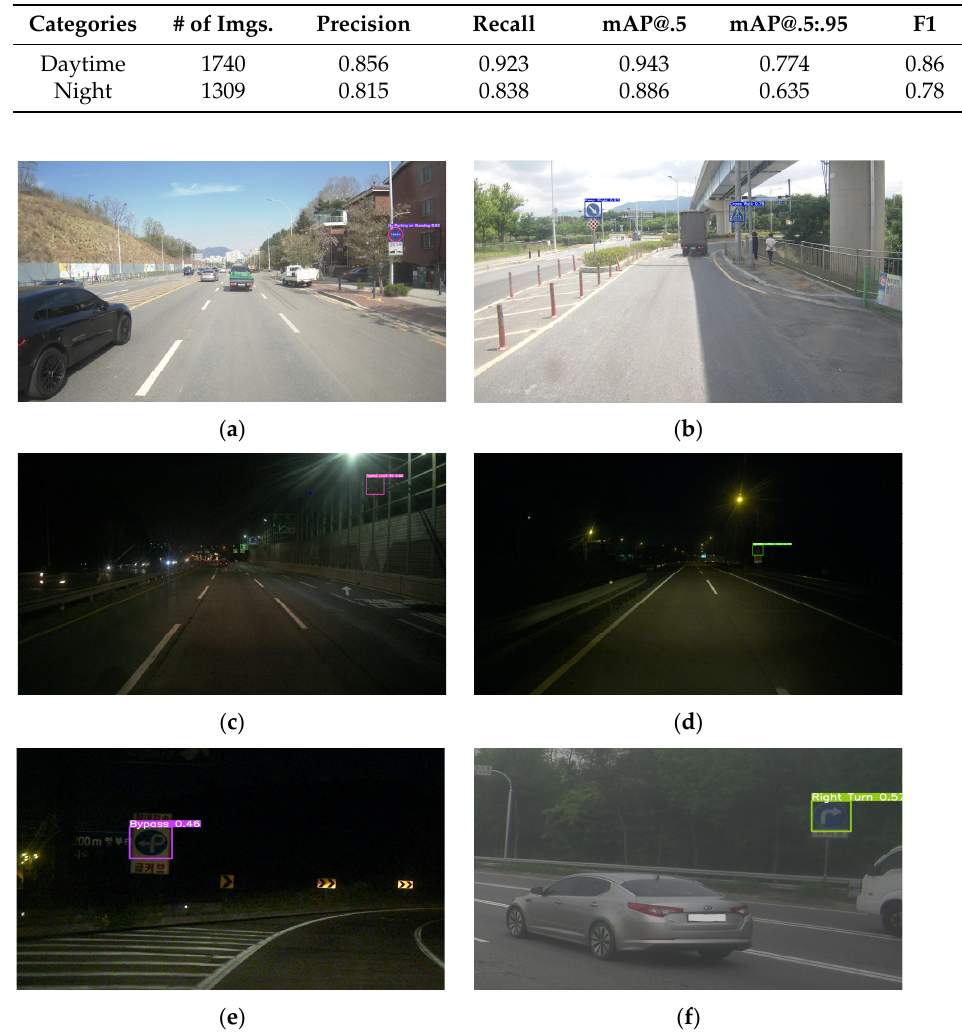
Figure 6. Examples of traffic sign recognition results in daytime and at night time: ( a ) Daytime (0.92), ( b ) Daytime (0.78), ( c ) Night (0.60), ( d ) Night (0.78), ( e ) Night (0.46), and ( f ) Daytime (0.57). Note that the numbers in the brackets indicate the minimum confidence score for the accurately recognized traffic signs in the examples. Table 5. Comparison of the recognition performance in different amounts of light.